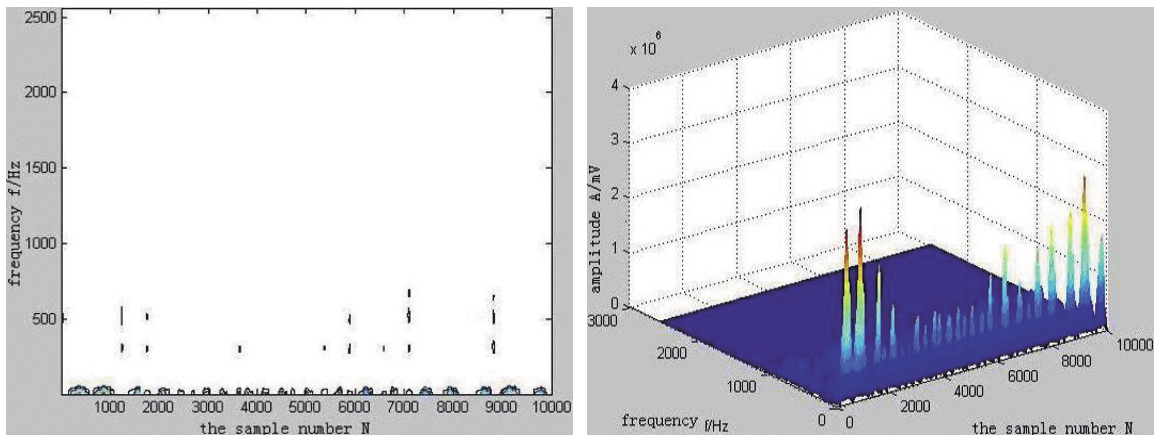
Fig. 6. The time frequency analysis of a tooth root crack signal at 300